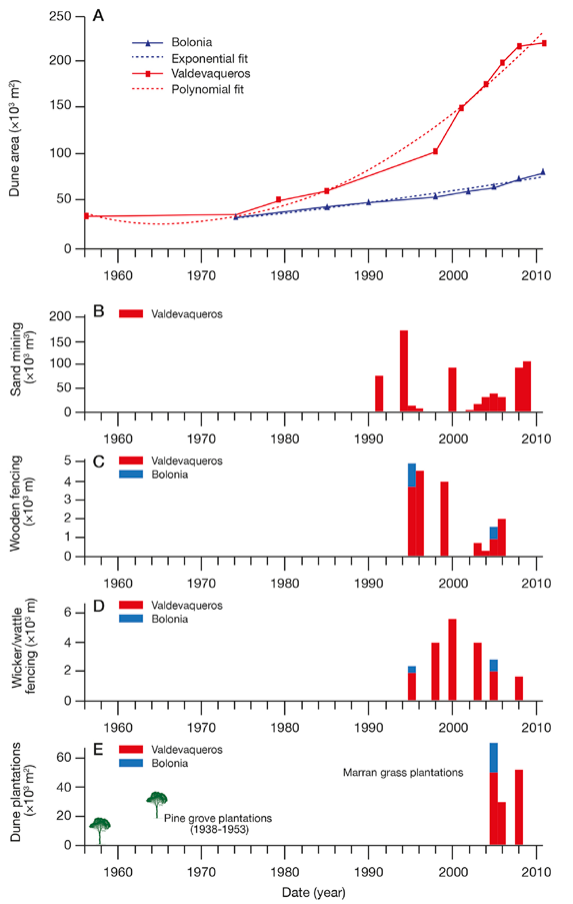
Fig. 12. – A, dune area evolution for Bolonia and Valdevaqueros during the research period (1956-2011). B, sand mining activities. C, wooden fencing. D, Wicker or wattle fencing. E, dune